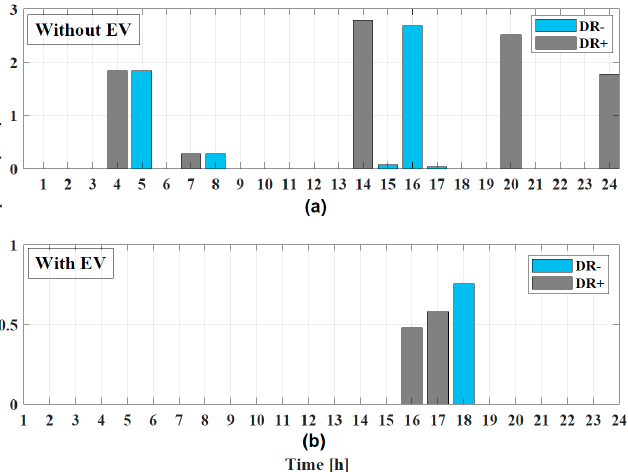
Figure 6. The profile related to DR+ and DR − . ( a ) is representing the DR status without presence of EV while ( b ) is with presence of